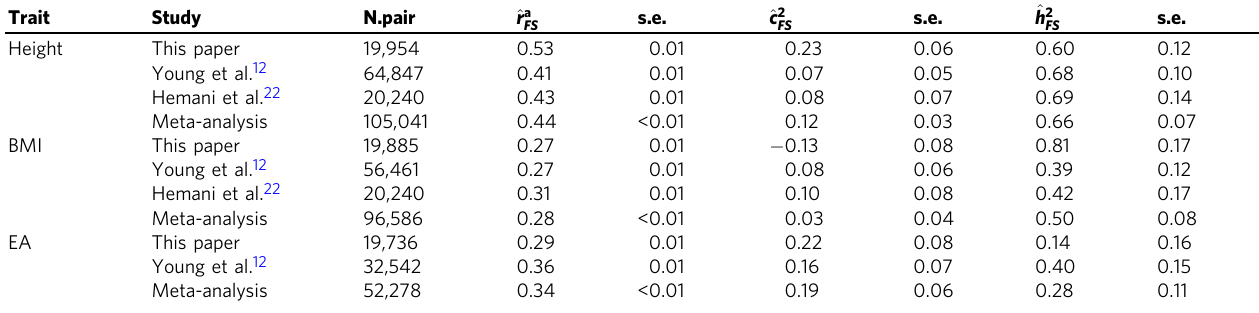
Table 3 Meta-analysis of full-sib IBD regression results for height, body mass index (BMI) and educational attainment (EA). Trait